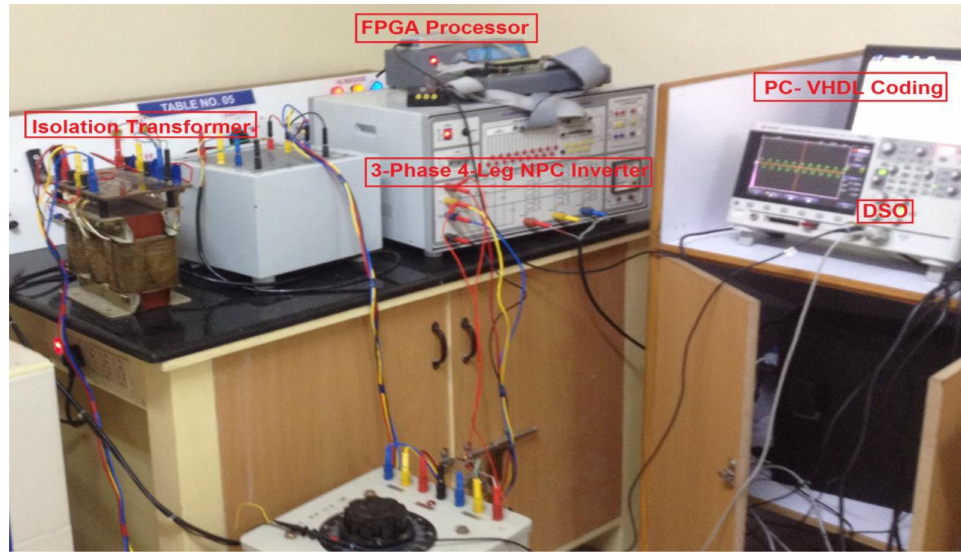
Figure 17. Experimental setup of proposed system.